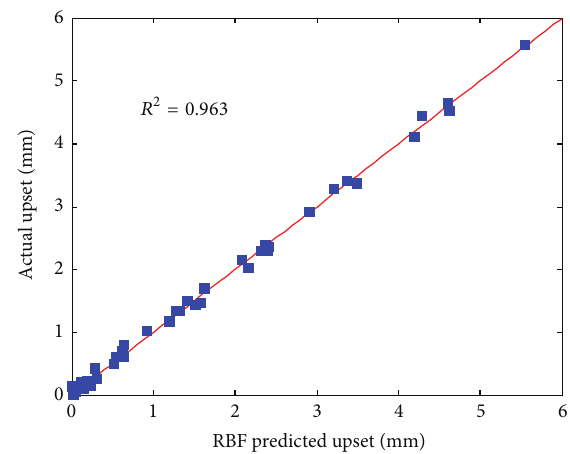
Figure 10: Parameter window based on the predicted upset by RBF network.